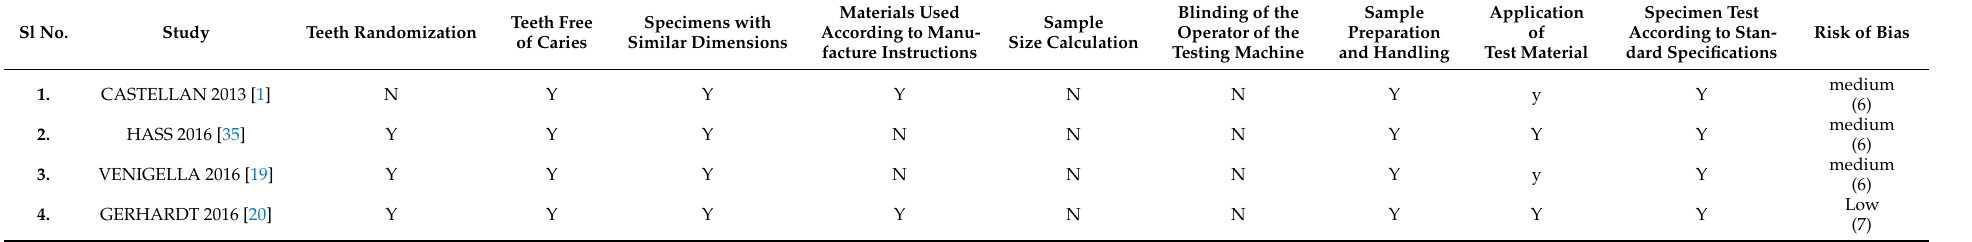
Table 3. Risk of bias of studies considering characteristics reported in the material and methods